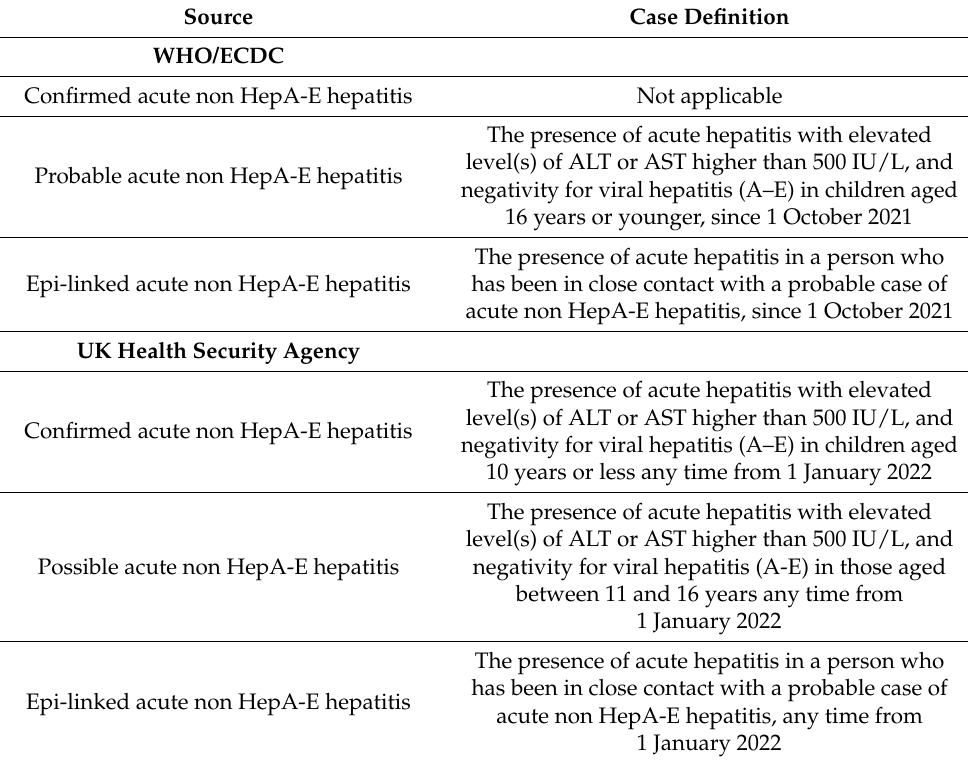
Table 1. Working case definition of acute non HepA-E